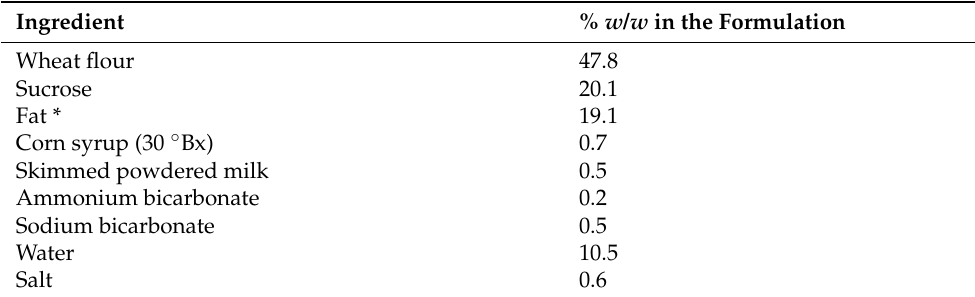
Table 4. Composition of cookie dough